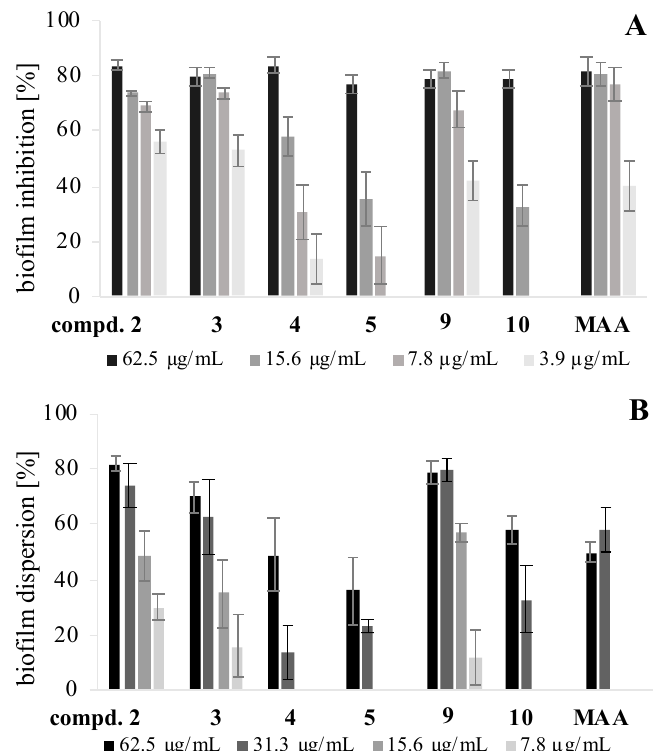
Figure 3. Effects of various concentrations of compounds 2 – 5 , 9 , and 10 on the formation of ( A ) and the dispersion of preformed ( B ) biofilms of S. aureus ; positive control: microporenic acid A (MAA); error bars indicate SD of two repeats with duplicates.